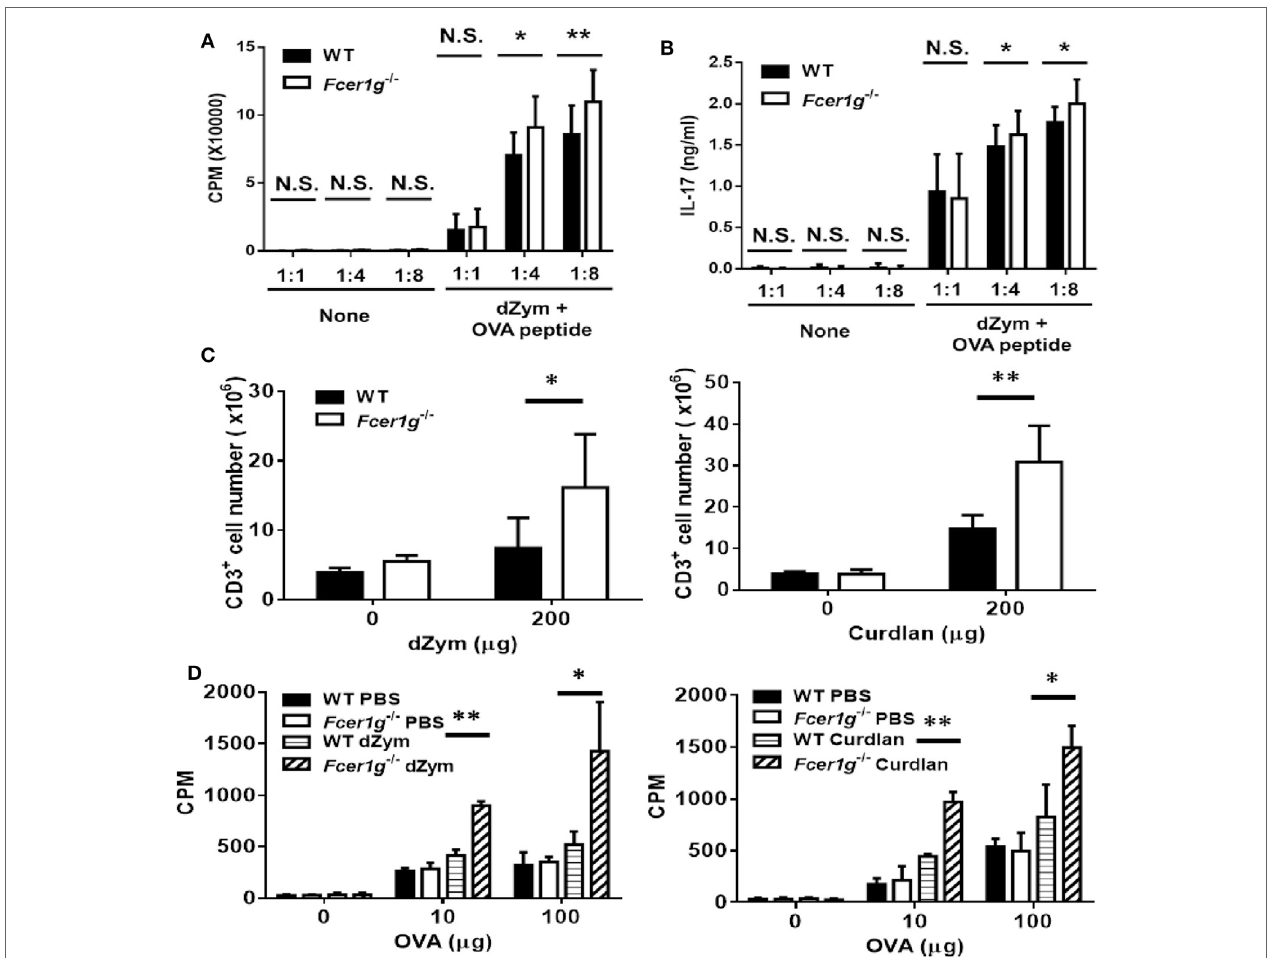
FigUre 6 | OVA-specific T cell responses were promoted in Fcer1g − / − mice. (a,B) Six-day-cultured BMDCs derived from WT and Fcer1g − / − mice were pulsed with OVA323-339 peptide for 3 h, then CD4 + OT-II T cells isolated from OT-II transgenic mice were cultured with these BMDCs at indicated ratios for 3 days. The proliferation of T cells was determined by [ 3 H]thymidine incorporation (a) and IL-17 production was detected by ELISA (B) . (c,D) WT and Fcer1g − / − mice were immunized with OVA (50 µg) mixed with incomplete Freund’s adjuvant and dZym (left panel) or curdlan (right panel) via footpads. After 7 days, the draining lymph nodes were isolated and total cells were collected. (c) The numbers of CD3 + cell were determined by counting and flow cytometry. (D) Total cells were cultured in 96-well plates with the indicated amounts of OVA for 3 days. The proliferation of T cells was measured by [ 3 H] thymidine incorporation. Error bars indicated mean + SD of three independent experiments. The significances * p < 0.05, ** p < 0.01 (Student’s t -test) were obtained by comparing Fcer1g − / − to WT dendritic cells. All data shown are representative from three independent